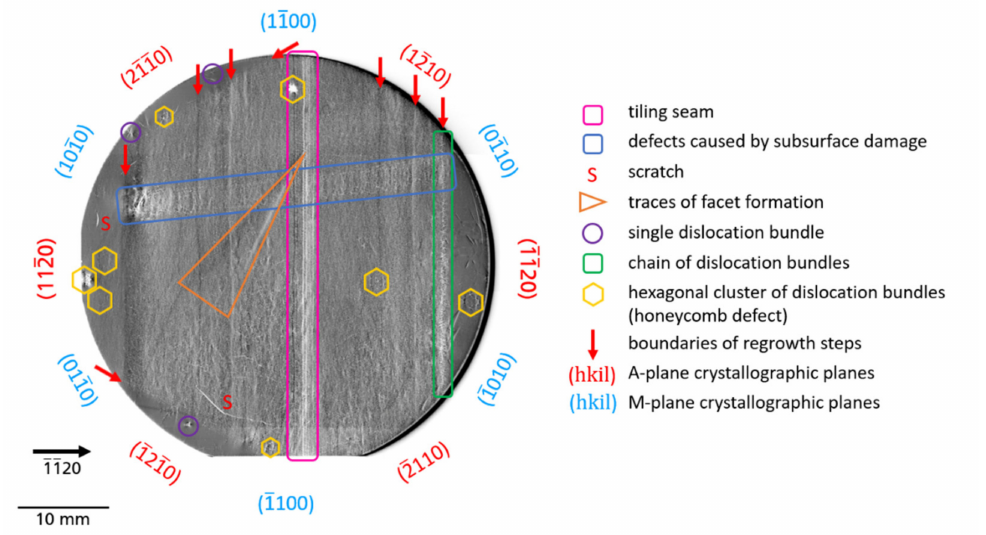
Figure 3. Overview of the typical macroscopic defects found in the Am-GaN ( 0001 ) substrates investigated, using substrate B as an